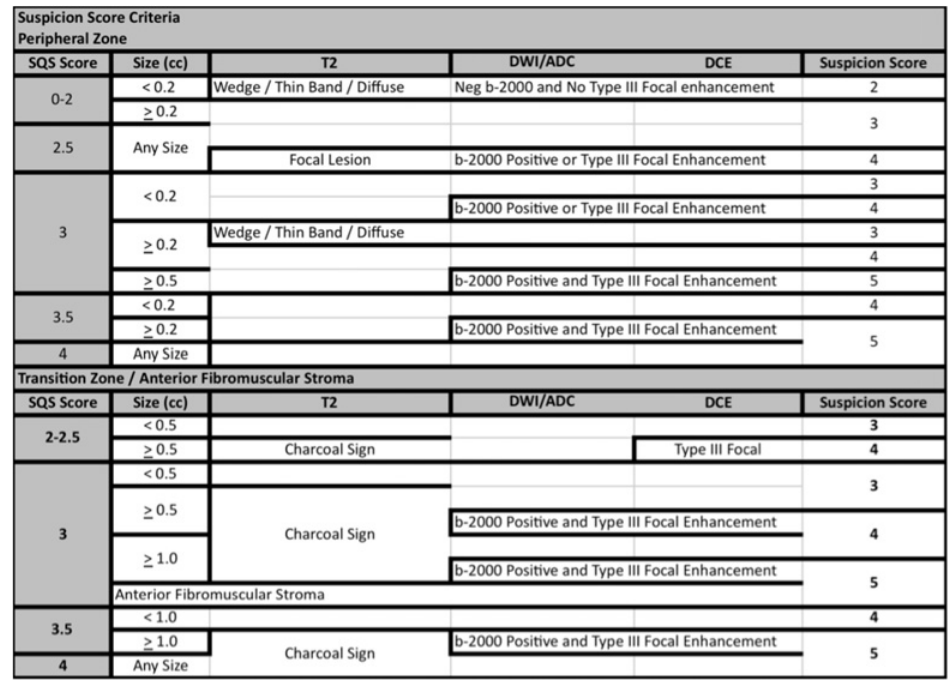
Fig 4. SQS Scoring System, Step 2: Calculate Overall SQS suspicion score. Select PZ or TZ then use the raw score to select the initial level of suspicion. Next move left to right taking into account the T2, ADC, DCE findings. You must meet all the criteria on each line to obtain the overall suspicion score on the right side of the table; otherwise use the lower score.